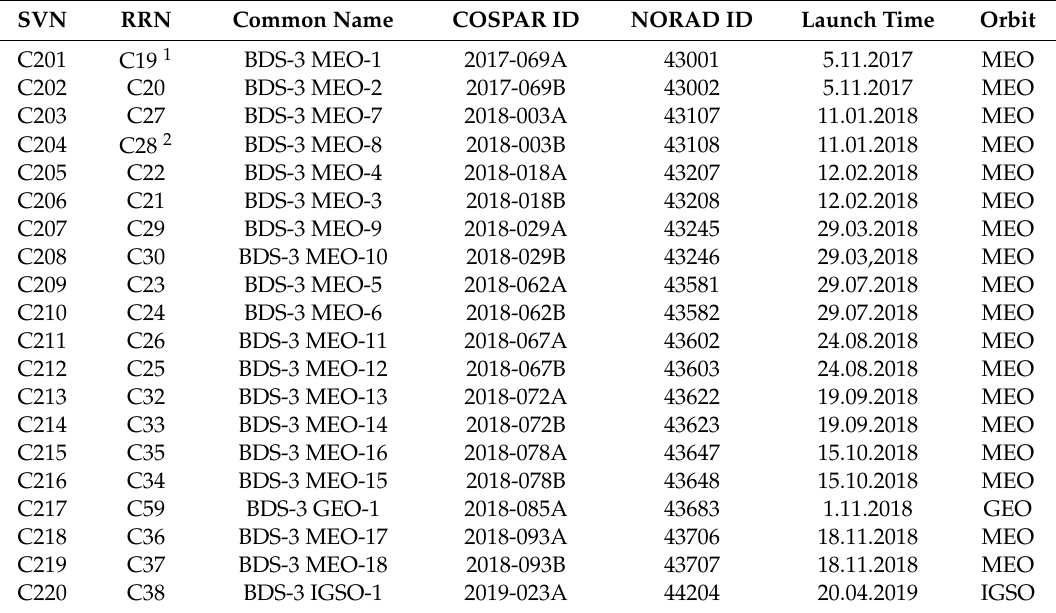
Table 1. The status of launched BDS-3 operational satellites (early May 2019)